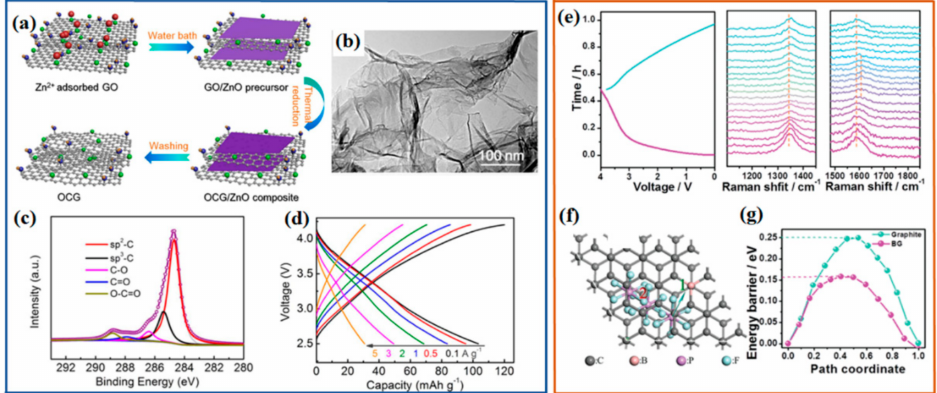
Figure 6. Graphite/graphene as cathode for post-Li capacitors. ( a – d ) Oxygen-functionalized graphene (OCG) as cathode for Na-ion hybrid capacitors: ( a ) schematic illustration of the synthesis of OCG, ( b ) TEM image, ( c ) C 1s XPS analysis, and ( d ) charge–discharge curves at different current densities. Reproduced with permission [44], Copyright 2018, Elsevier. ( e – g ) B-doped graphite (BG) as cathode for sodium-ion hybrid capacitors: ( e ) in situ electrochemical–Raman spectroscopy test of the BG electrode in an Na-ion hybrid capacitor, ( f ) optimized PF 6 diffusion in B-doped graphite layers, and ( g ) the corresponding energy barriers from DFT calculations. Reproduced with permission [66], Copyright 2018, Royal Society of